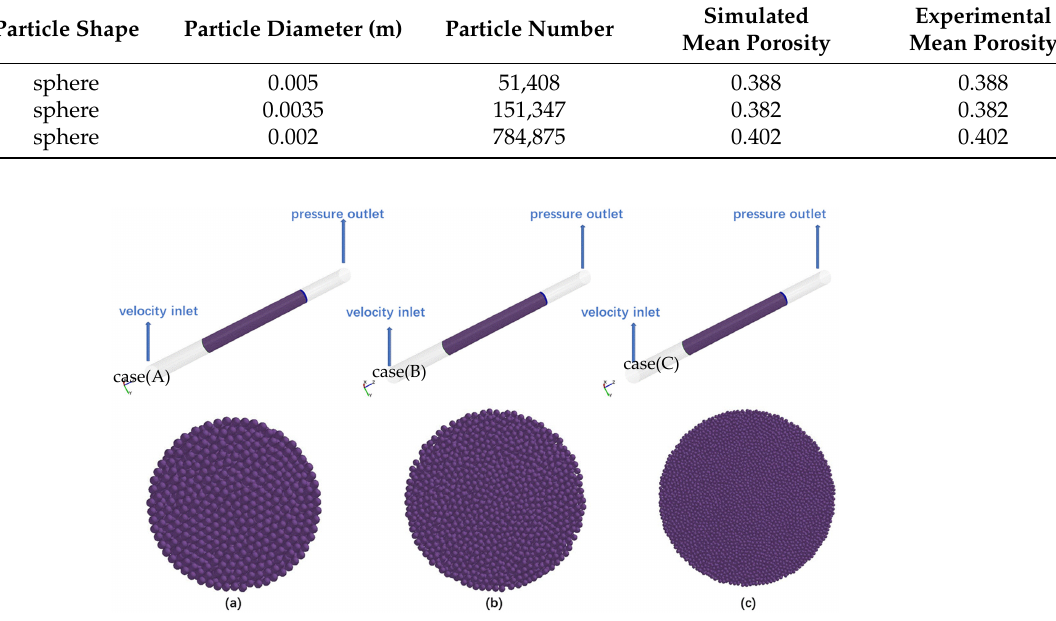
Figure 1. Three cases based on experimental study of Park et al. [34]: ( a ) case ( A ) d i = 0.005 m; ( b ) case ( B ) d i = 0.0035 m; and ( c ) case ( C ) d i = 0.002 m. Table 1. Characteristics of sphere particle beds.